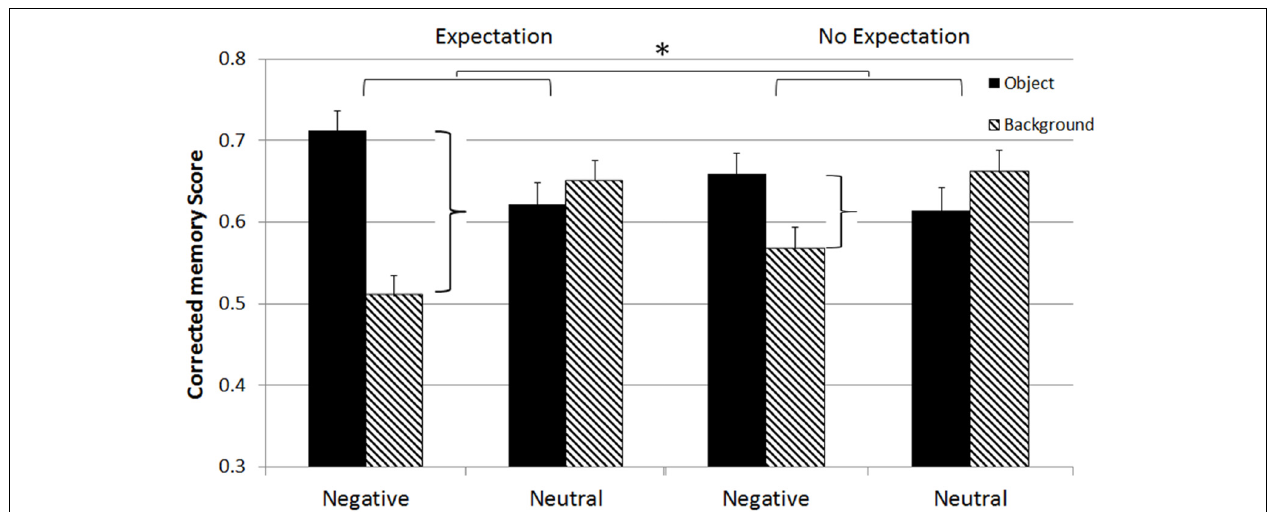
FIGURE 2 | Expectation × Valence × Scene component three-way interaction. * p <